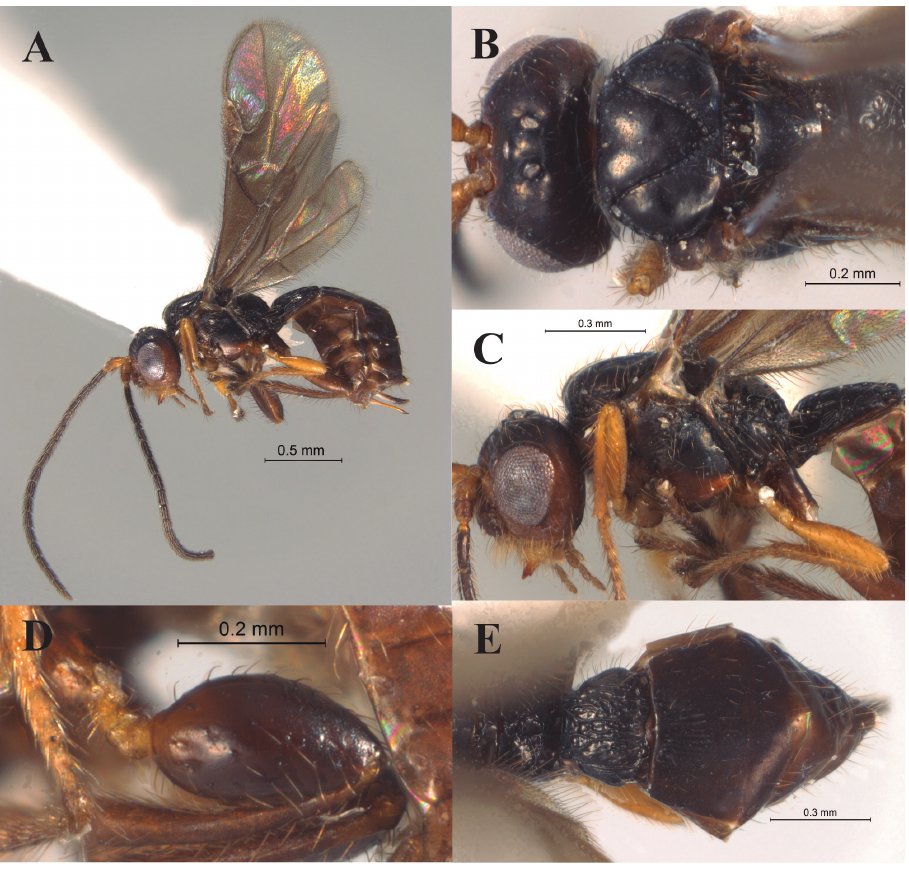
Figure 3. Labania minuta Marsh (female A–C, E ; male D ): A habitus, lateral view B head and mesosoma, dorsal view C head and mesosoma, lateral view D hind femur E metasoma, dorsal Updated key to species of Labania (after Marsh 2002) 1 Body length 1.0–1.8 mm (Fig. 3A). Antenna with less than 20 segments ..... ..................................................................... L. minuta Marsh (Fig. 3A–E). – Body length 2.5–4.1 mm (Fig. 1A). Antenna with more than 20 segments ..... 2 2 Second metasomal tergite completely smooth (Fig. 1E). Mesosoma and metasoma mainly or entirely black or dark reddish brown (Figs 1A, C, D, E). Wings distinctly darkened (Figs 1A, F, G, 2A) ........................................... 3 – Second metasomal tergite longitudinally striate basally. Mesosoma and meta- soma at least partly brown. Wings mainly subhyaline ................................. 4 3 Transverse diameter of eye 1.4–1.7 times wider than temple. Eye covered with long and very dense setae. Malar space 0.4–0.5 times height of eye. Propodeum mainly smooth, rugose only medially. Discoidal (first discal) cell